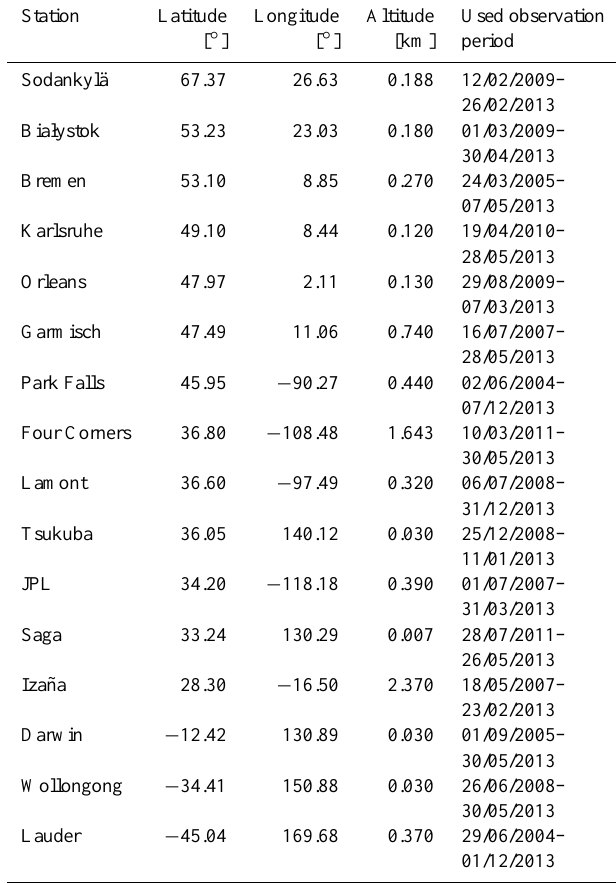
Table 4. Used TCCON sites, their location, altitude (above sea level) and used observation